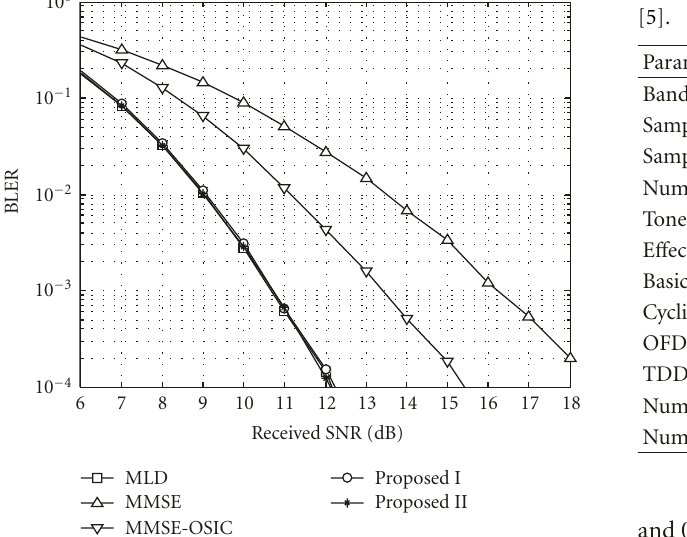
Figure 7: Comparison of the BLER performance of the first PSS for the proposed and the conventional schemes when both MSs transmit with (QPSK, 3/4).